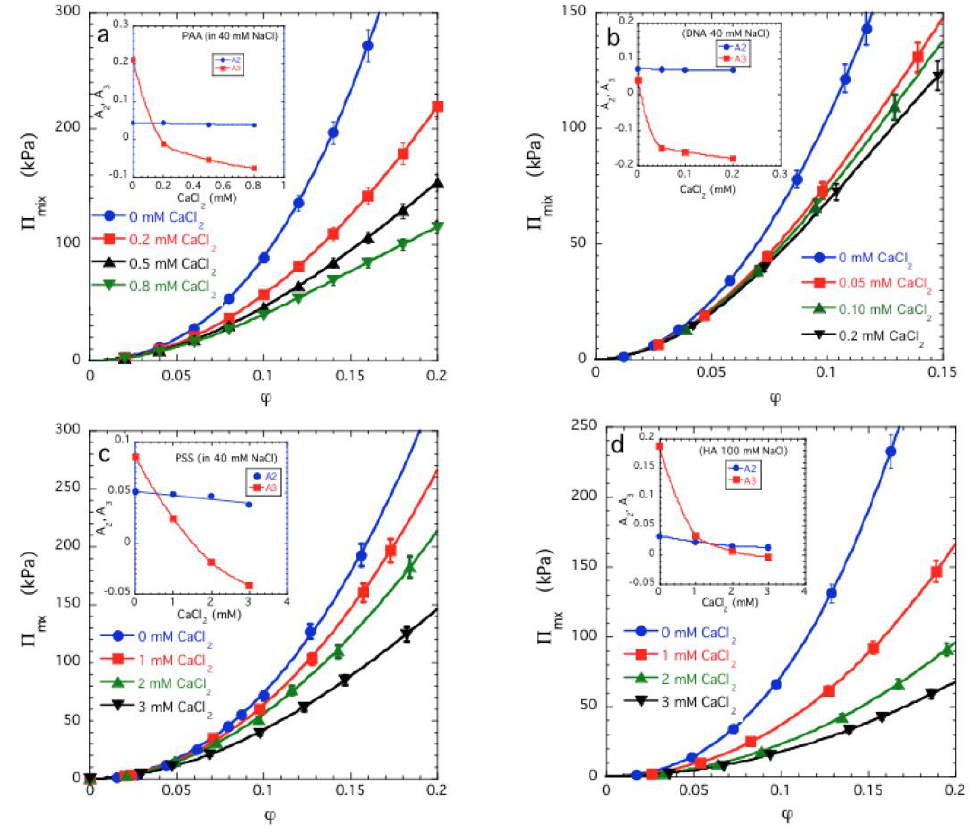
Figure 2. Mixing pressure Π mix versus polymer volume fraction φ plots for sodium polyacrylate (PAA) ( a ), DNA ( b ) and PSS gels ( c ) in 40 mM NaCl solution with different CaCl 2 concentrations, and for HA gels ( d ) in 100 mM NaCl with different CaCl 2 concentrations. The continuous lines show the fits of Equation (3) to the experimental data. Insets: Variation of A 2 and A 3 as a function of the CaCl 2 concentration. The data uncertainties are estimated by one standard deviation of the linear regression fit parameters.